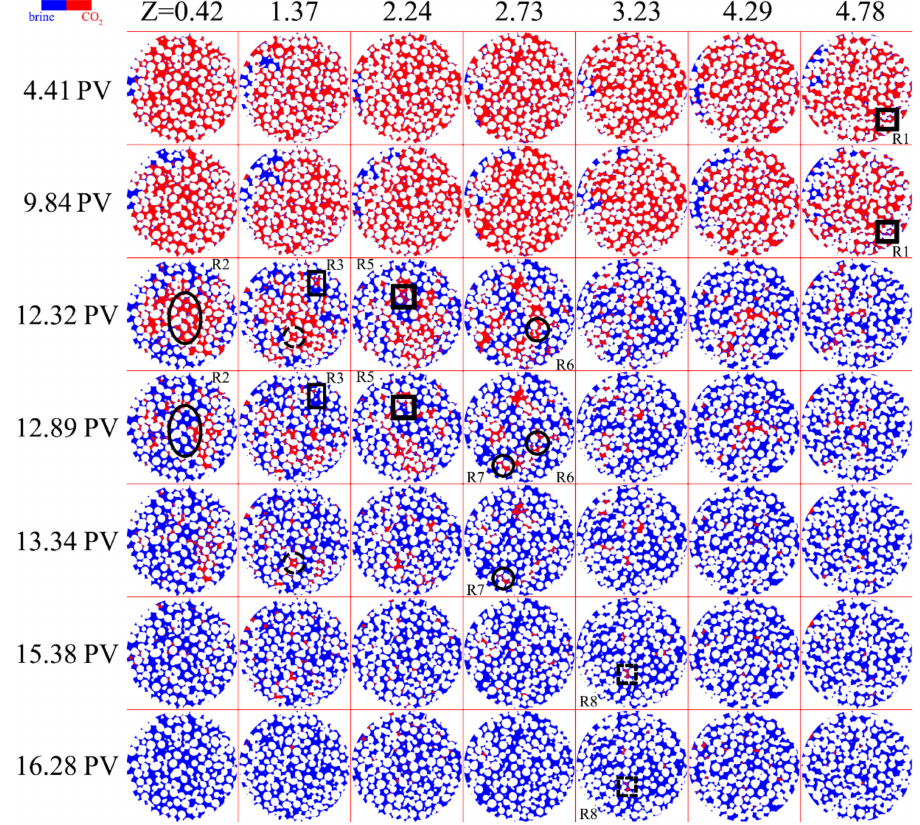
Figure 2. Time-lapse images of the supercritical CO 2 (red) at different positions for 0.04 mL/min. The position of the image along the vertical direction of the brine injection is short as Z, which is also the distance from the